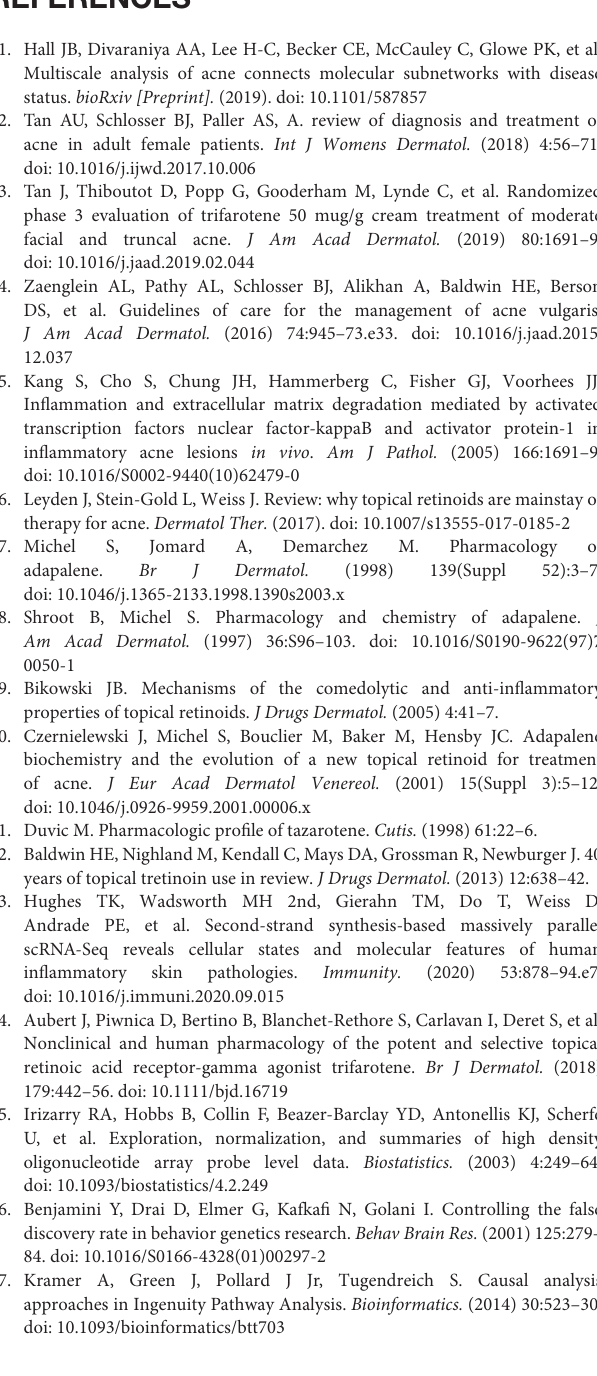
Supplementary Table 6 | Disease and functions analysis of the 69 genes specifically modulated in spontaneously resolved acne papules. This table represents a selection of disease or functions with the highest activation z-scores comparing papule signature (L1 vs L-NI) and vehicle signature (L3 vs L1) (FDR < 0.05, z -score > 1.5). We can observe a reverse activation z -score between the expression levels in the papule (L1 vs. LNI) and after spontaneous resolution (L3 vs.